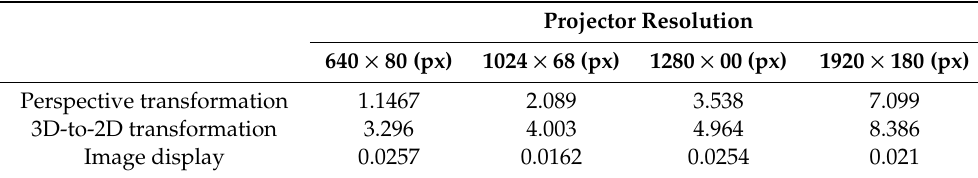
Table 1. Results of data processing times for dynamic video mapping of a sheet of paper.